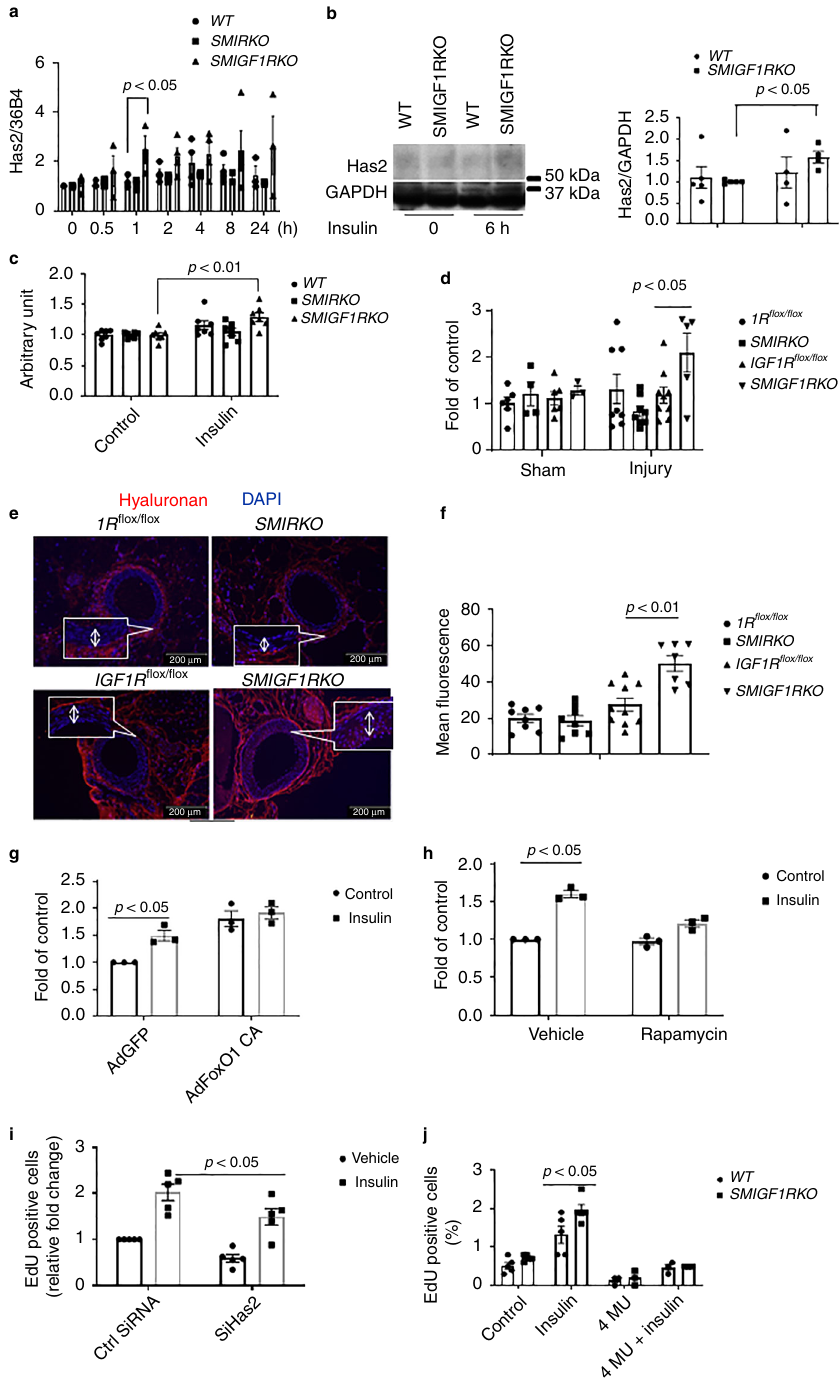
Fig. 7 Has2 expression in VSMCs and femoral artery. a Starved WT , SMIRKO , or SMIGF1RKO VSMCs were stimulated with 10nM insulin, and the gene expression